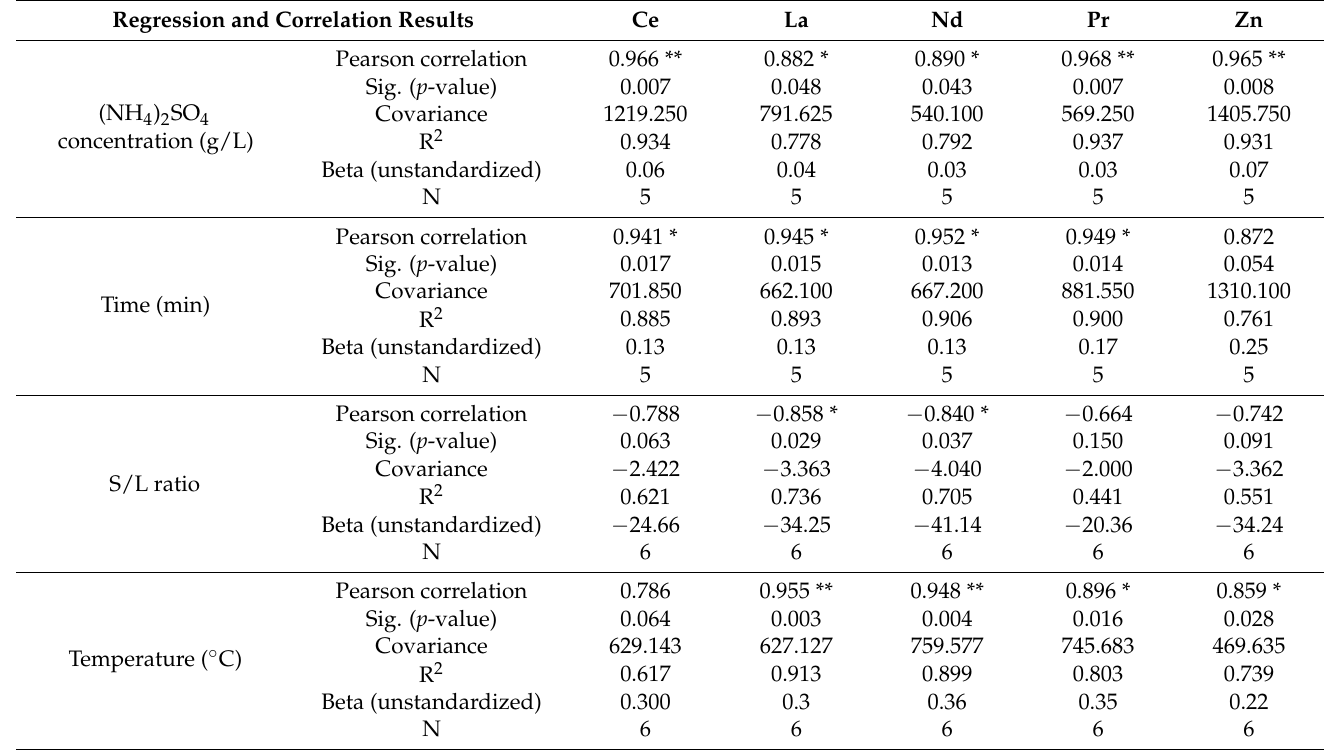
Table 4. Regression and correlation results between leaching factors and REEs.